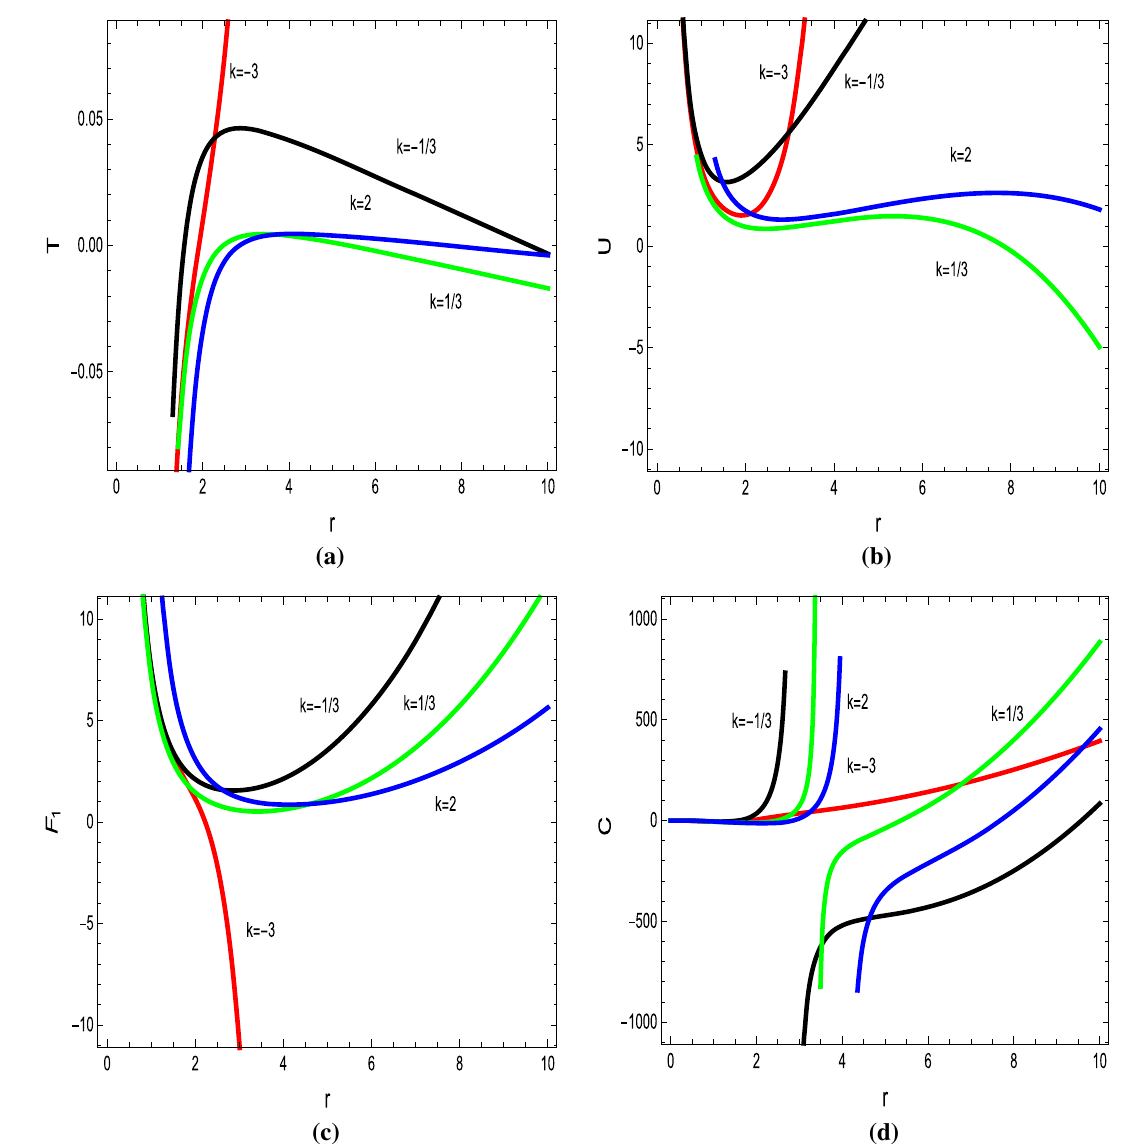
parameter k in Brans–Dicke gravity’s rainbow. The other parameters are fixed at α = 0 . 1 ,β = 0 . 2, t = 2, n = − 1, ω = − 0 . 5 γ =